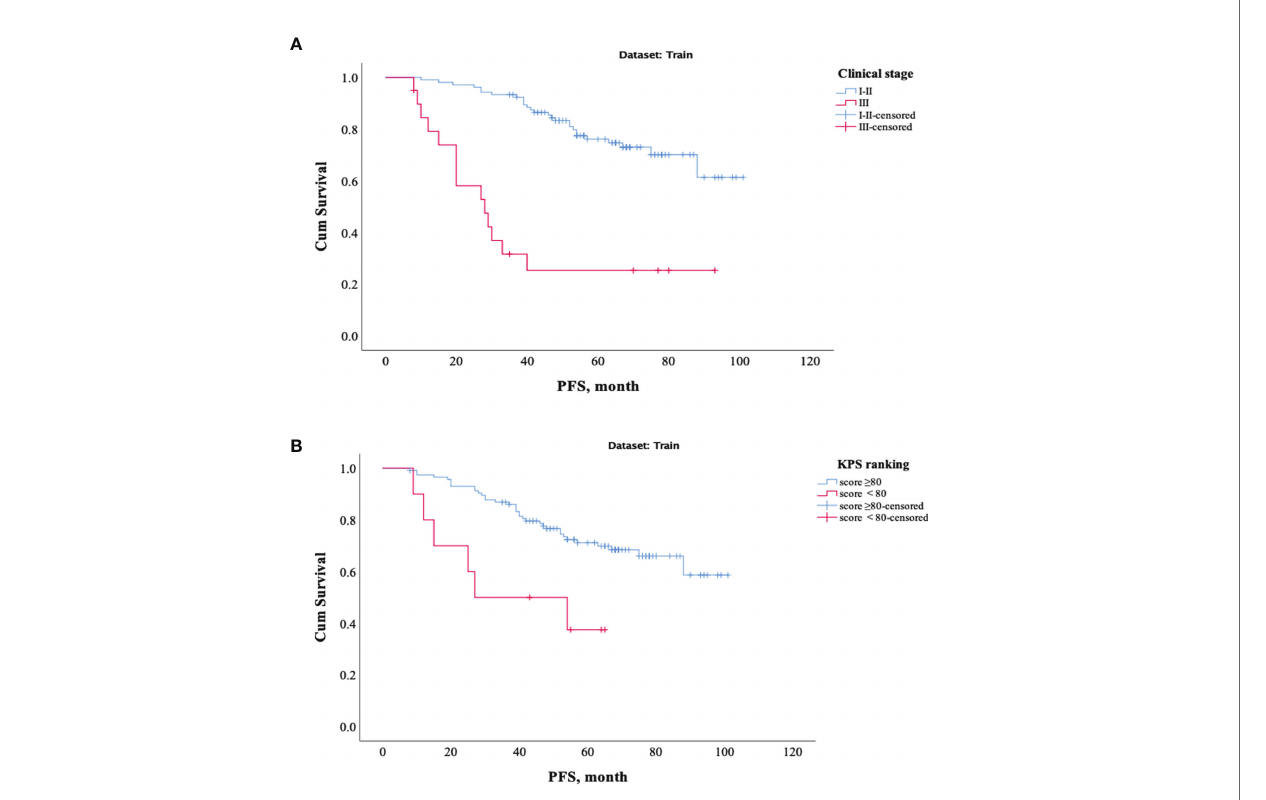
FIGURE 3 | Kaplan – Meier survival analysis of PFS in the training set. (A) Clinical stage. (B) KPS score.